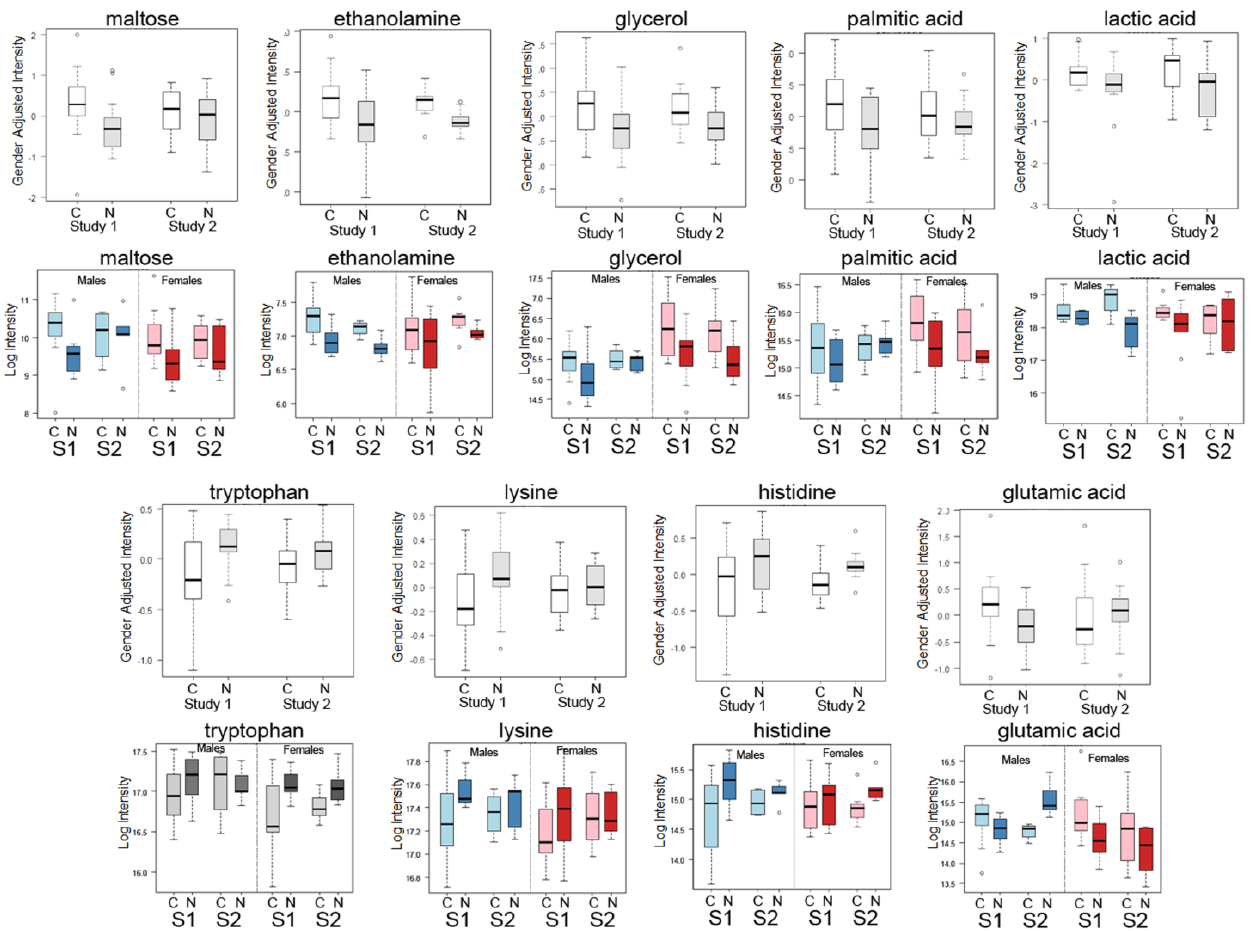
Figure 1. Box-whisker plots of top metabolite candidates in Study 1 and Study 2 with additional plots of the same metabolites from each study separated by gender (males and females). Box-whisker plots of gender adjusted intensities of top known metabolite candidates from Study 1 (S1) compared with the same compounds in Study 2 (S2) for cancer cases (C) and normal/control (N) showing similarity in the changes in both studies are shown for nine of the top metabolites: maltose, ethanolamine, glycerol, palmitic acid, lactic acid, tryptophan, lysine, histidine and glutamic acid. Shown below each metabolite plot are results for the same metabolites separated by gender. Blue plots denotes male results only and red plots denote females results only for each